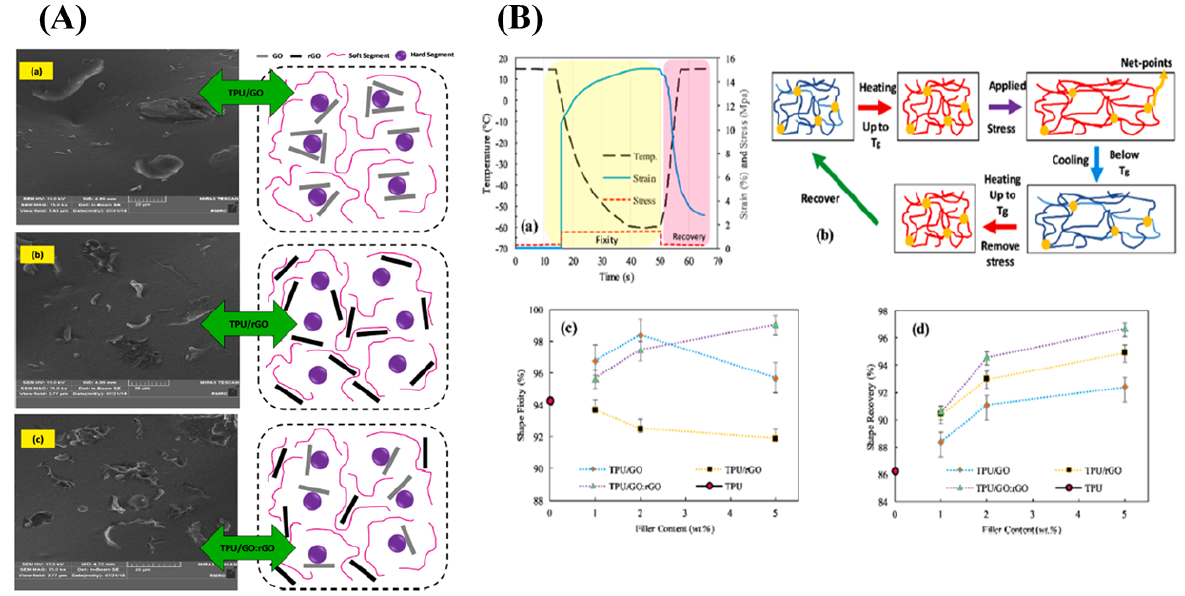
Figure 5. ( A ) Illustrated morphology of the GO-based shape memory material (TPU/GO: rGO) [( a ) GO platelets, ( b ) rGO platelets, and ( c ) GO:rGO hybrid filler] and the ( B ) molecular mechanism of the shape memory behaviour, shape fixity, and shape recovery [( a ) Shape memory thermo-mechanical cycle, ( b ) The molecular mechanism of Shape memory behavior (Blue lines: molecular chains with low mobility below Tg; red lines: molecular chains with high mobility above Tg), ( c ) shape fixity and ( d ) shape recovery on neat TPU, TPU/GO, TPU/rGO and hybrid TPU/GO:rGO composites with 1, 2 and 5 wt% filler content] (Reproduced with permission from [30], Elsevier, 2019).